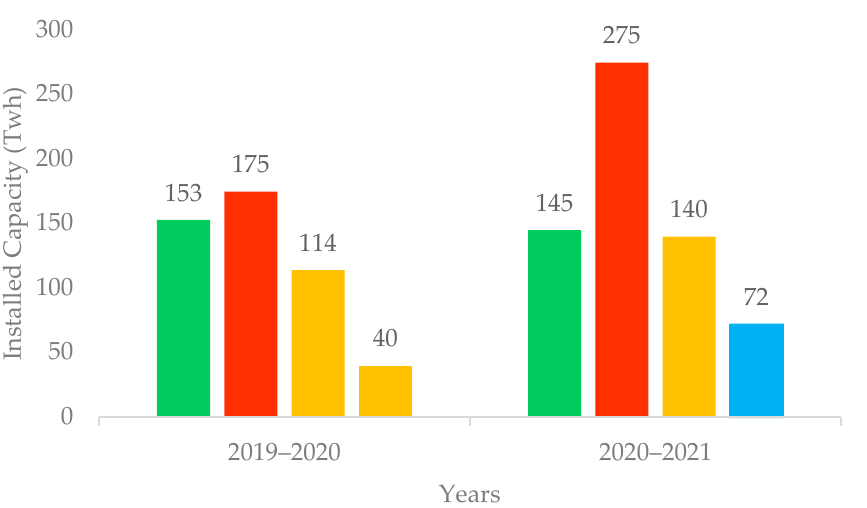
Figure 1. Renewable energy technologies in TWh with their respective years of penetration; source: authors’ depiction based on IEA data [4].